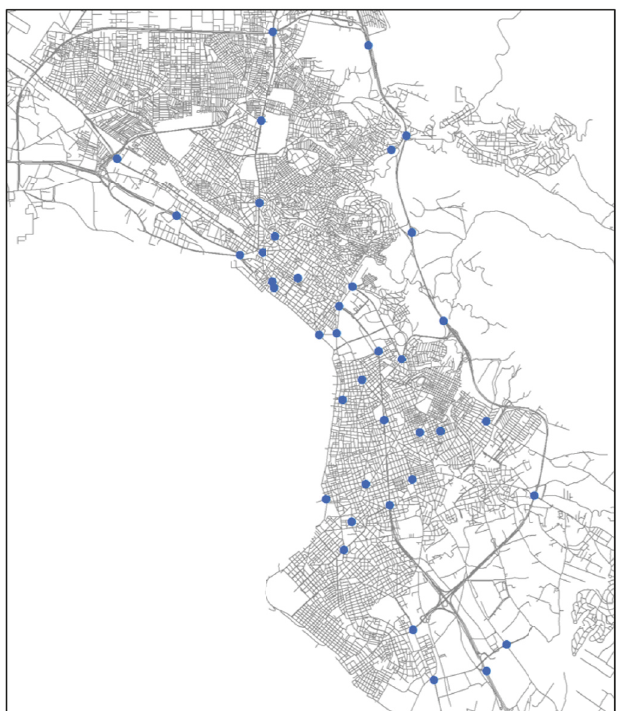
Figure 2: BT detectors network in the city of Thessaloniki.